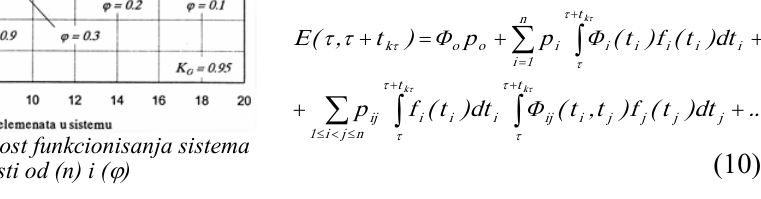
Dijagram 1 – Efektivnost funkcionisanja sistema u zavisnosti od (n) i ( ϕ